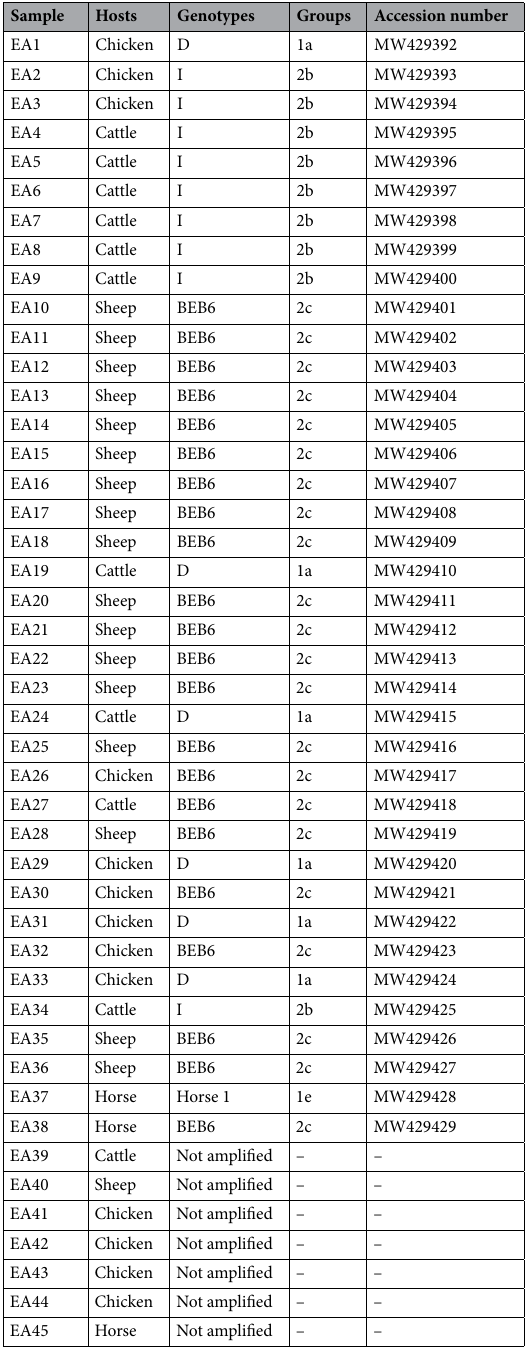
Table 3. Genotype distribution, classification, and accession numbers of E. bieneusi- positive